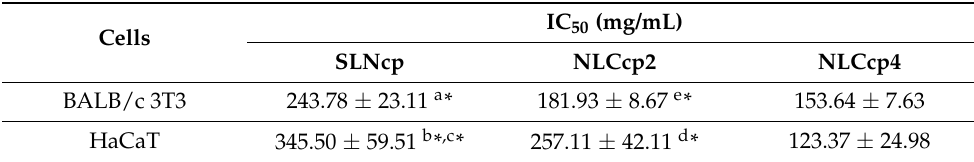
Table 4. IC 50 of lipid nanoparticles in 3T3 and HaCaT culture